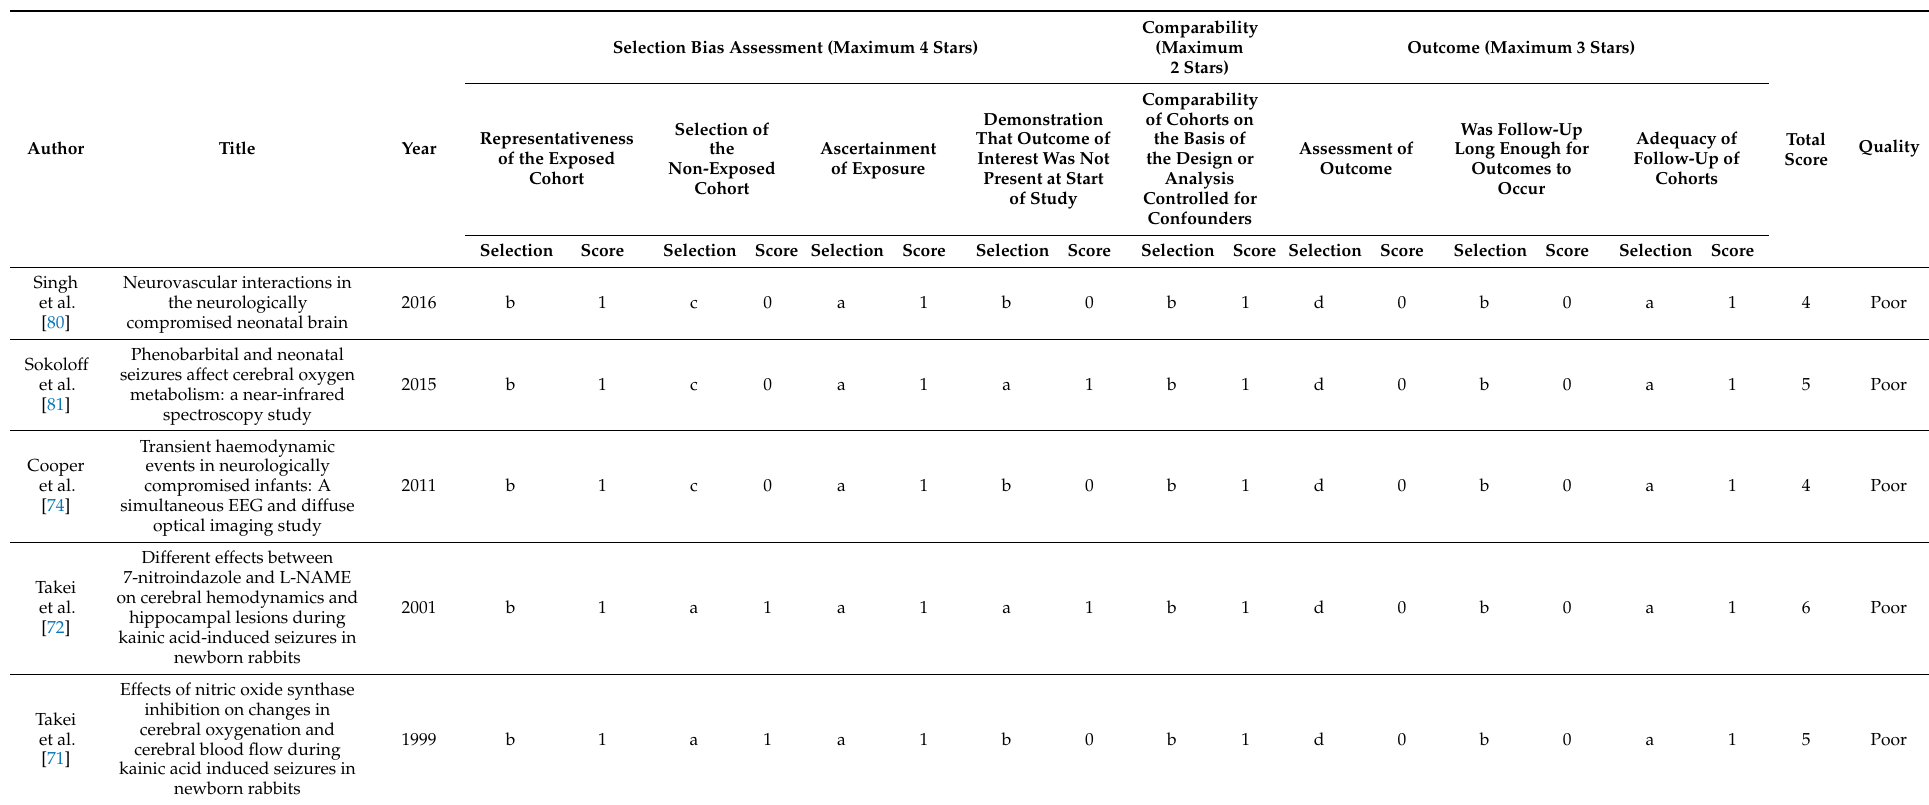
Table A1. Newcastle-Ottawa Scale appraisal of included cohort